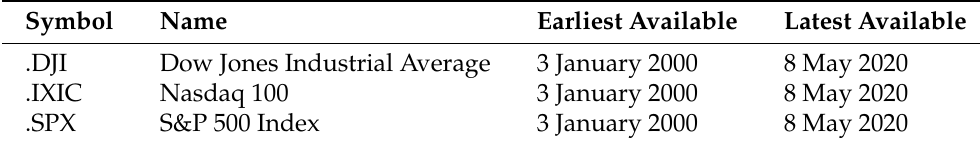
Table 2. Oxford-Man’s Realized Library: U.S. stock